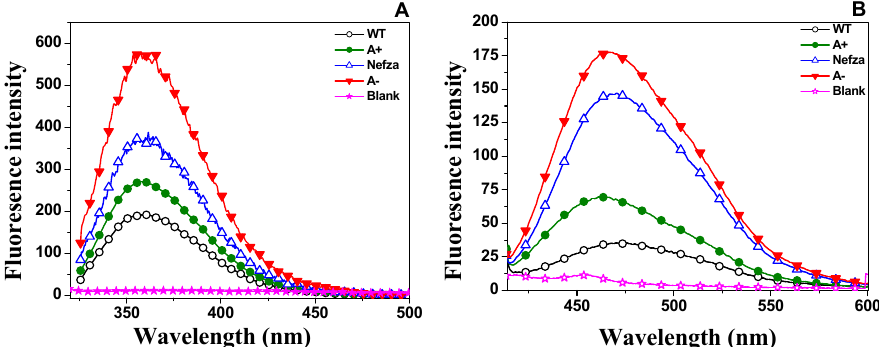
Figure 8. Fluorescence emission spectra of the G6PD variants. ( A ) Intrinsic fluorescence spectra of recombinant human WT G6PD and three clinical variants G6PD A+; Nefza and A − in the absence of NADP + ; ( B ) 8-Anilinonaphthalene-1-sulphonate (ANS) accessibility assays of WT G6PD and the three clinical variants in the absence of NADP + . Values obtained from buffer containing ANS without protein (open stars) were subtracted from the recordings with protein. The experimental conditions for all the experiments are described in the Materials and Methods section.